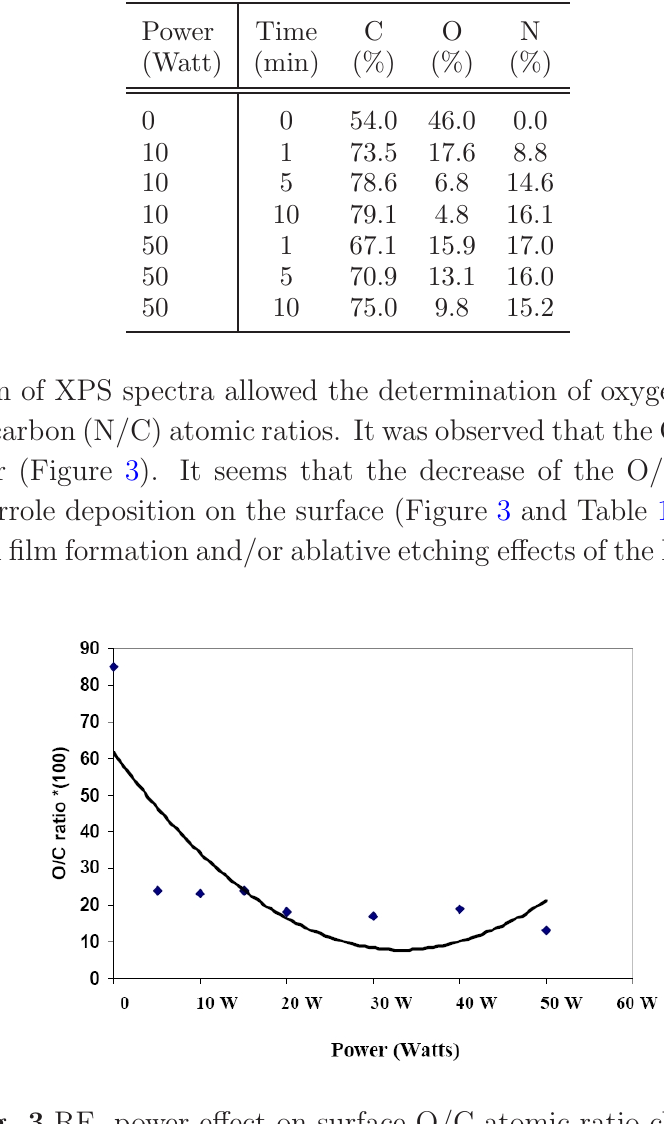
Fig. 3 RF- power effect on surface O/C atomic ratio